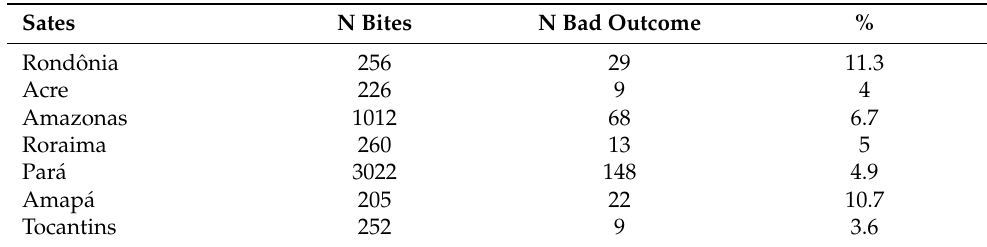
Table 6. Number of snakebites with information of all covariables, number of bad outcomes of the accident and percentages, rural population, Brazil,